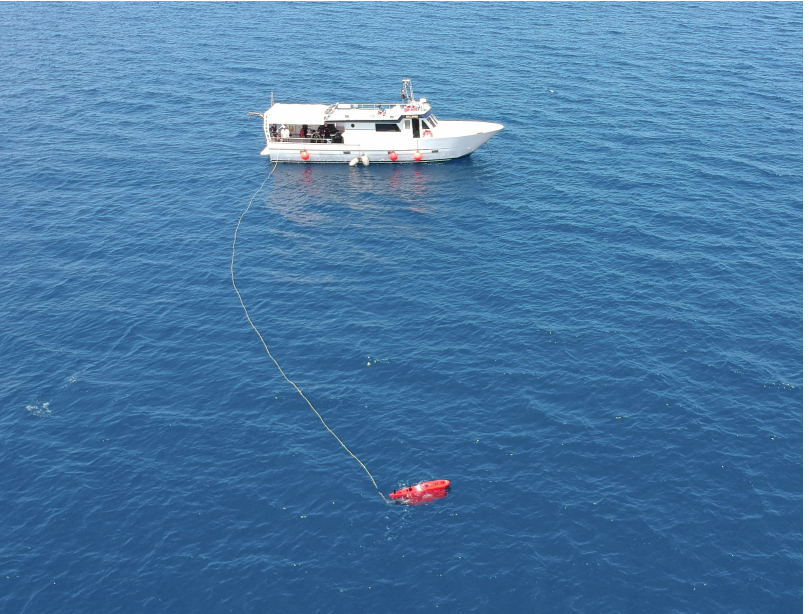
Figure 11. Blucy deployment from surface vessel in ROV mode during SUSHI DROP project